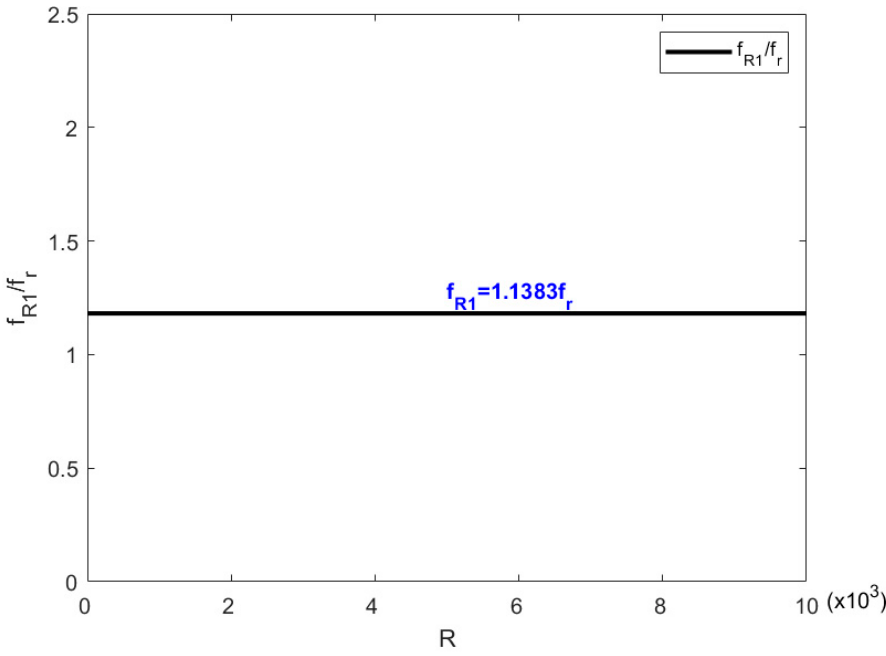
Figure 17. The change in 𝑓 (cid:2902)(cid:2869) with the resistance